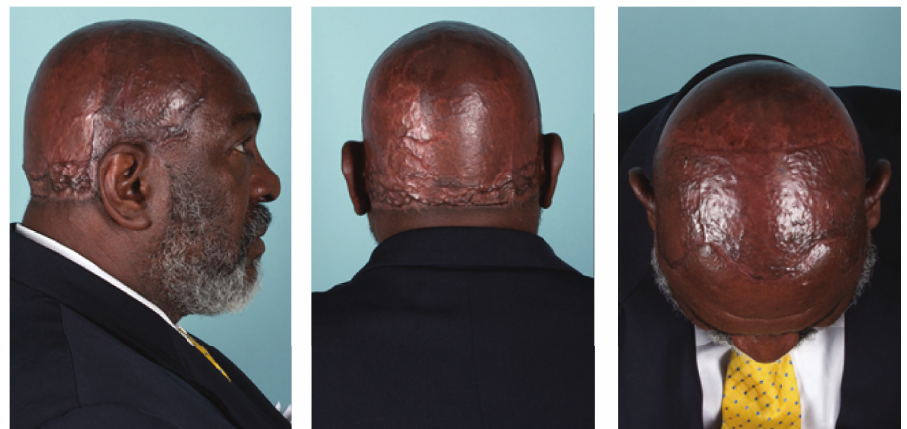
Figure 3: Postoperative (1 year) appearance showing good take and healing of the split-thickness skin